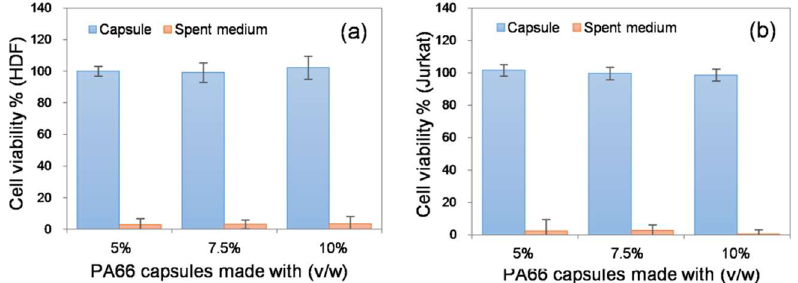
Figure 6. Cell encapsulation study: ( a ) Adherent cells (human dermis fibroblasts, HDF) and ( b ) non-adherent cells (lymphocytes from human peripheral blood, Jurkat cells) were encapsulated in the electrospun capsules. The number of cells present at day 3 remained unaffected in comparison to cultures on standard tissue culture-treated polystyrene dishes. Spent media showed no detectable cell activity, suggesting that the capsules effectively compartmentalized the cells. No statistical differences were found within the capsule and spent medium groups.